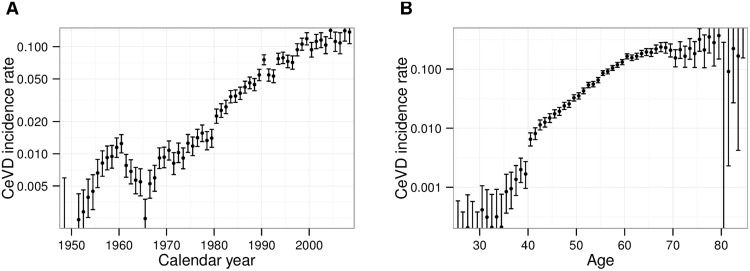
Crude CeVD incidence rates and 95% confidence intervals of the full cohort.(A) Crude rates for different calendar years. (B) Crude rates for different ages. The crude rate is the number of cases per person years.